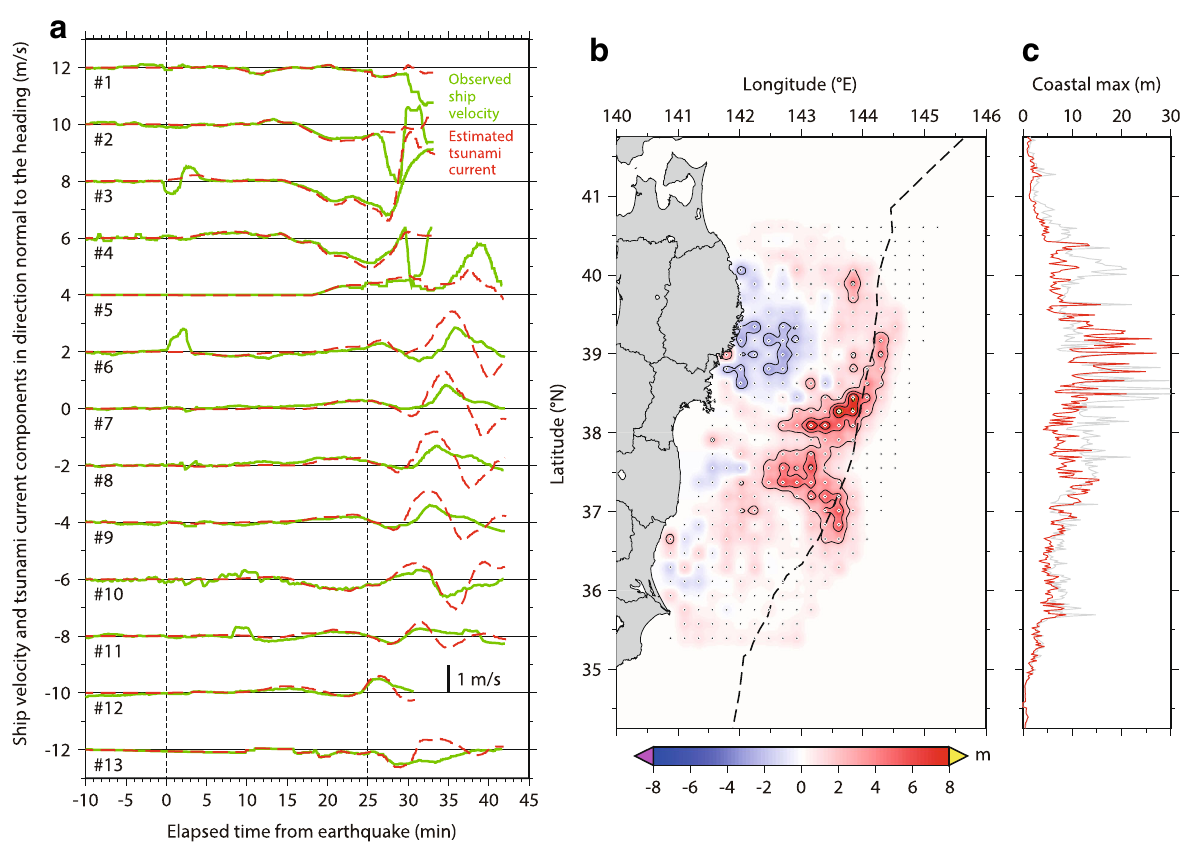
Fig. 7 Result of inversion using AIS data during 0 – 25 min after the earthquake occurrence: a observed ship velocity (green) and estimated tsunami current (red) in the HDG-normal direction, b estimated tsunami source, and c estimated maximum wave height at the coast. In b , dots are allocated unit sources. Red and gray curves in c are derived from the estimated source and from Fig. 1b,